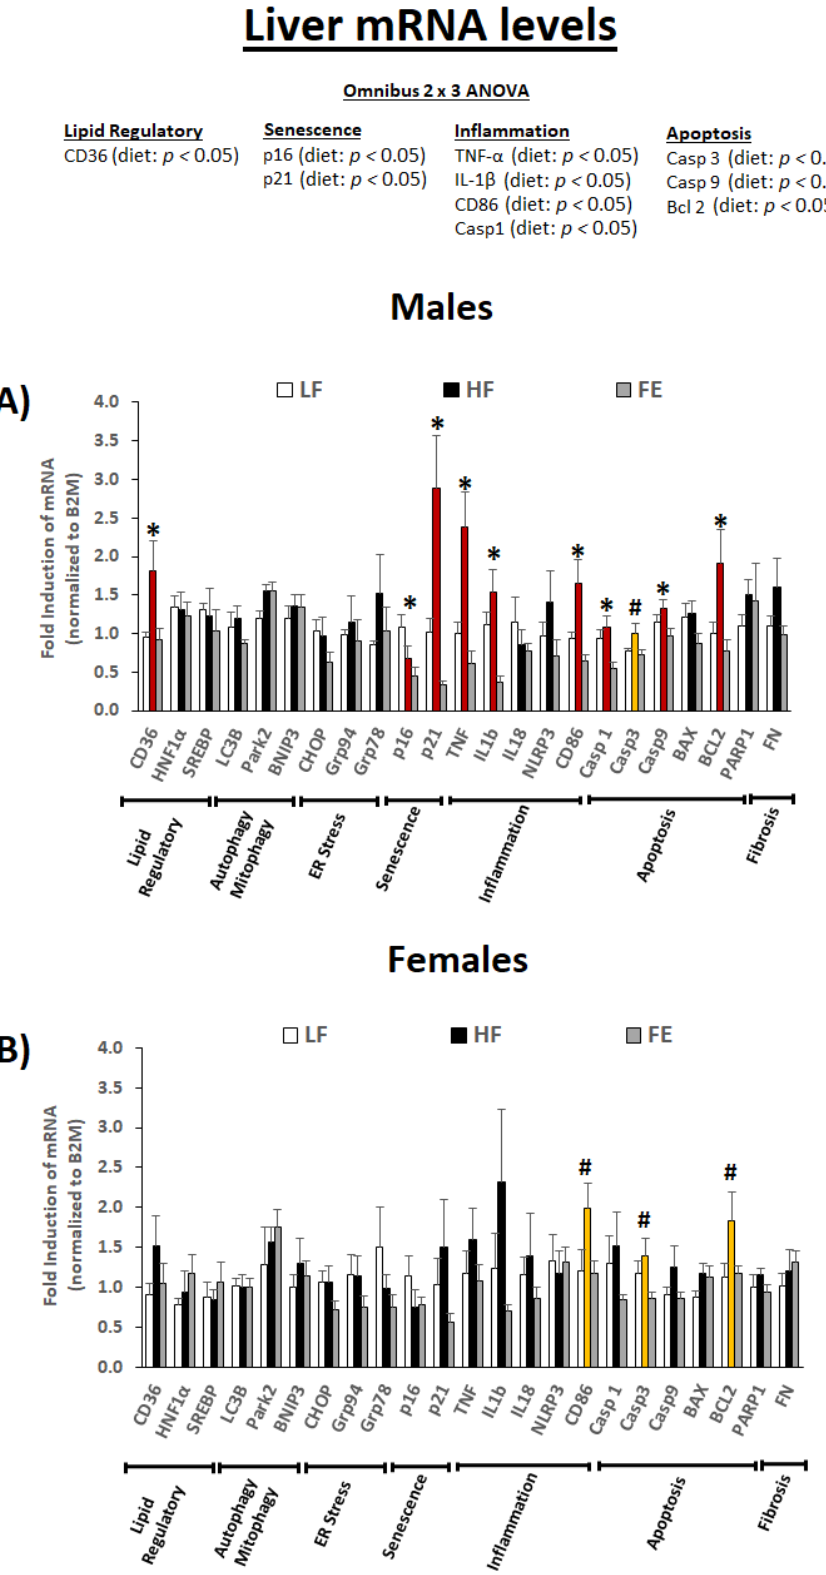
Figure 7. Effects of the ‘Fertility Enhancer’ supplement on liver mRNA levels in Western diet-fed C57BL/6J mice. * Significant one-way ANOVA within sex ( p ≤ 0.05). # Borderline significant one-way ANOVA within sex ( p ≤ 0.1).